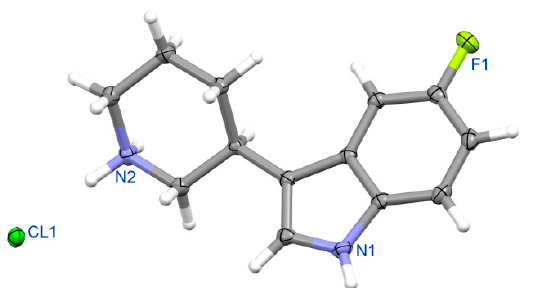
17 of 21 Figure 12. View of molecular structure of enantiomeric fluoro- derivative (R)-10b . (3S)-5-fluoro-3-(piperidin-3-yl)-1H-indole hydrochloride (S)-11b (Figure 13) 1 H-NMR (500 MHz, D 2 O): δ 7.44 (C7”H, [1H], 4d, 3 J = 9.0, 4 J H-F = 5.0, 5 J = 0.5), 7.35 (C4”H, [1H], 4d, 3 J H-F = 10.0, 4 J = 2.5, 5 J = 0.5), 7.24 (C2”H, [1H], s), 7.03 (C6”H, [1H], 8d, 3 J = 9.5, 3 J H-F = 8.0, 4 J = 2.5, p J = 0.5), 3.56 (CaH(E). [1H], m), 3.49 (CeH(E), [1H], m), 3.22 (CbH, [1H], tt, 3 J A-A = 12.0, 3 J A-E = 3.5), 3.01 (CeH(A), [1H], td, 2 J = 3 J A-A = 13.0, 3 J A-E = 3.5), 2.98 (CaH(A), [1H], t, 2 J = 3 J A-A = 12.5), 2.01–2.14 (CcH(E),CdH(E), [2H], m), 1.83–1.95 (CdH(A), [1H], m), 1.72 (CcH(A), [1H], kd, 2 J = 3 J A-A = 12.0, 3 J A-E = 4.0). 13 C-NMR (125 MHz, D 2 O): δ 156.9 (C5 ″ , d, 1 J = 231.9), 132.3 (C3 ″ , s), 125.1 (C3 ″ a, d, 3 J = 9.9), 123.3 (C2 ″ , s), 114.6 (C7 ″ a, d, 4 J = 4.8), 112.6 (C7 ″ , d, 3 J = 9.9), 109.8 (C6 ″ , d, 2 J = 26.4), 102.5 (C4”, d, 2 J = 23.8), 48.2 (Ca, s), 43.7 (Ce, s), 30.6 (Cb, s), 28.2 (Cc, s), 21.9 (Cd, s). ESI-HRMS m/z : Calcd for C 13 H 16 FN 2 [M+H] + 219.12975. Found: 219.12936 HPLC separation method: LUX Cellulose-3 5 μ m, 250 × 4.6 mm column; T = 35 °C; phase A: 0.05% diisopropylamine in ethanol/methanol 80/20; phase B: hexane; flow: 0.5 mL/min, 92% of phase B, isocratic elution; detection at 220 nm.